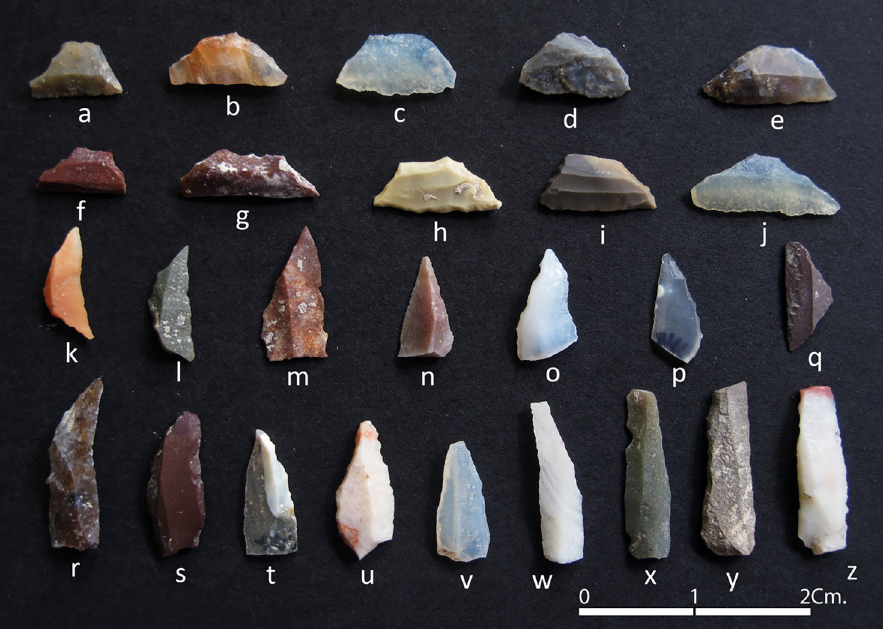
Fig 2. Examples of the lithic assemblage recovered from Vaharvo Timbo: a-j) trapezes, k-l) lunates, m-p) points, q) triangle isosceles and r-z) various types of blades. Courtesy of the Department of Archaeology and Ancient History, The M.S. University of Baroda, Vadodara. Photo credits: Ajithprasad P (North Gujarat Archaeological Project). (Fig 2). Raw materials belong to different types of crypto-crystalline siliceous materials includ- ing chert, chalcedony, banded agate, moss agate, carnelian, bloodstone and quartz. A few frag-